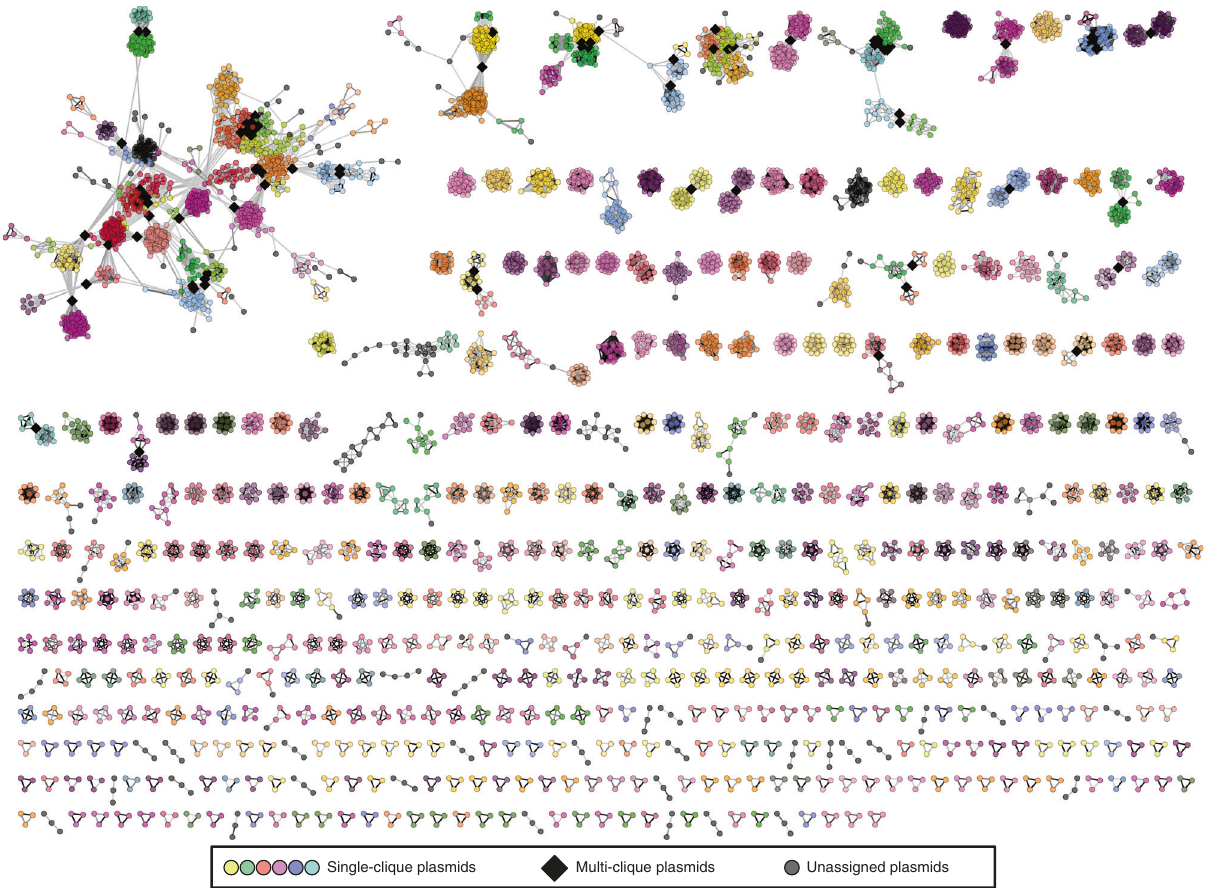
Fig. 3 Sparse network of plasmids assigned to cliques by OSLOM algorithm (network density = 0.00128). The network includes 5371 plasmids (nodes) assigned into 561 cliques (complete subgraphs). The completeness of identi fi ed cliques was evaluated based on the original network (Supplementary Fig. 3). 5008 unassigned plasmids, which formed disjoined singletons and pairs, were removed from the network. Coloured nodes indicate plasmids assigned to a single